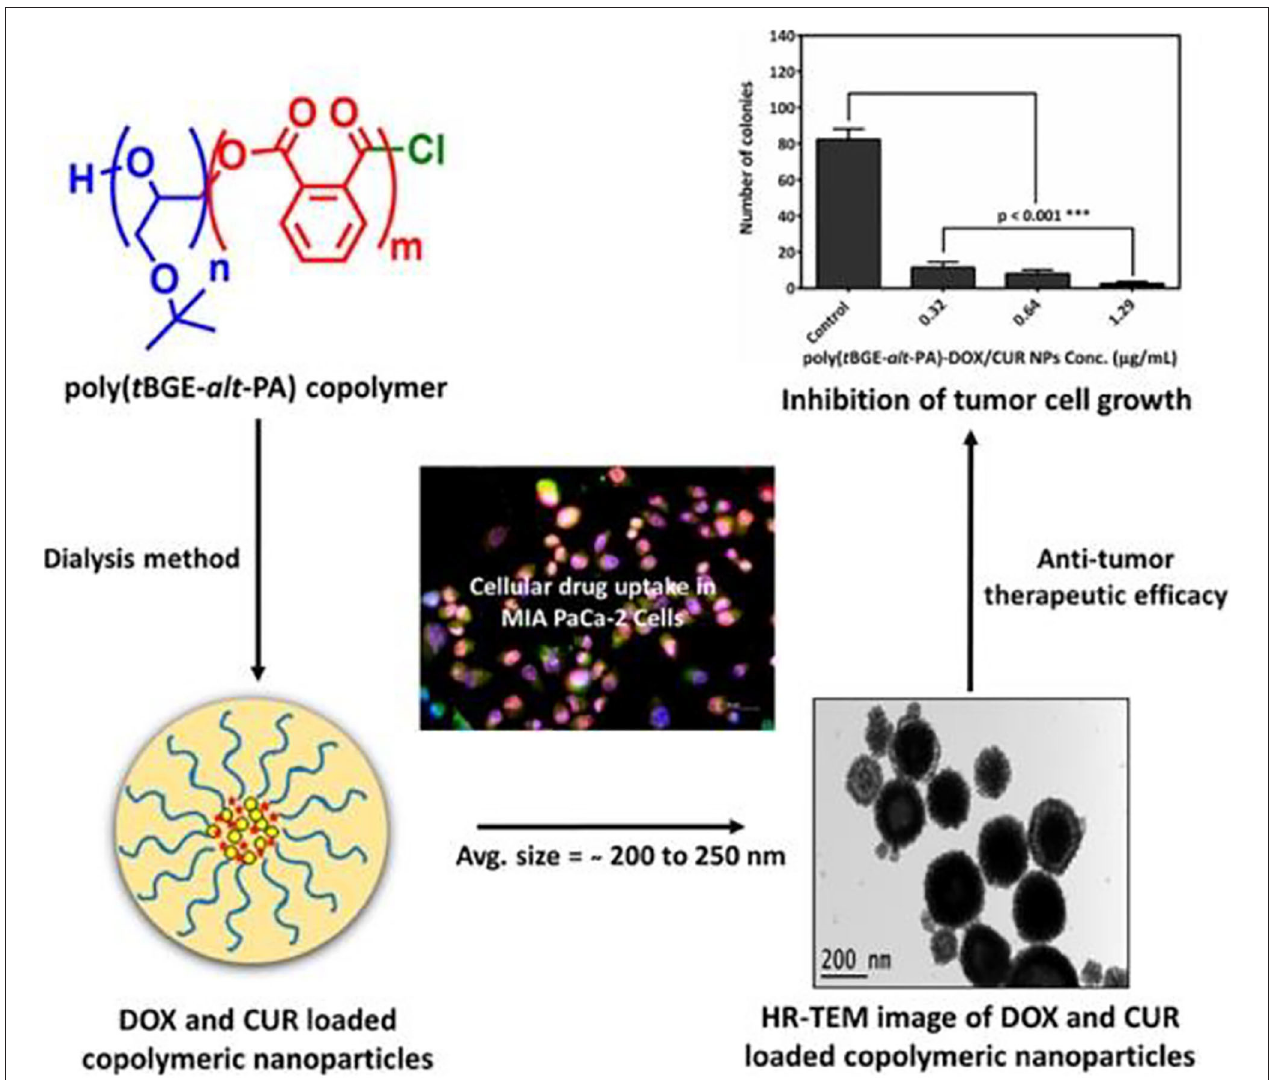
FIGURE 13 | Illustration of doxorubicin (DOX) and curcumin (CUR) loaded nanoparticles self-assembled from poly( t BGE- alt -PA). Adapted with permission from Gupta et al. (2019). Copyright 2019